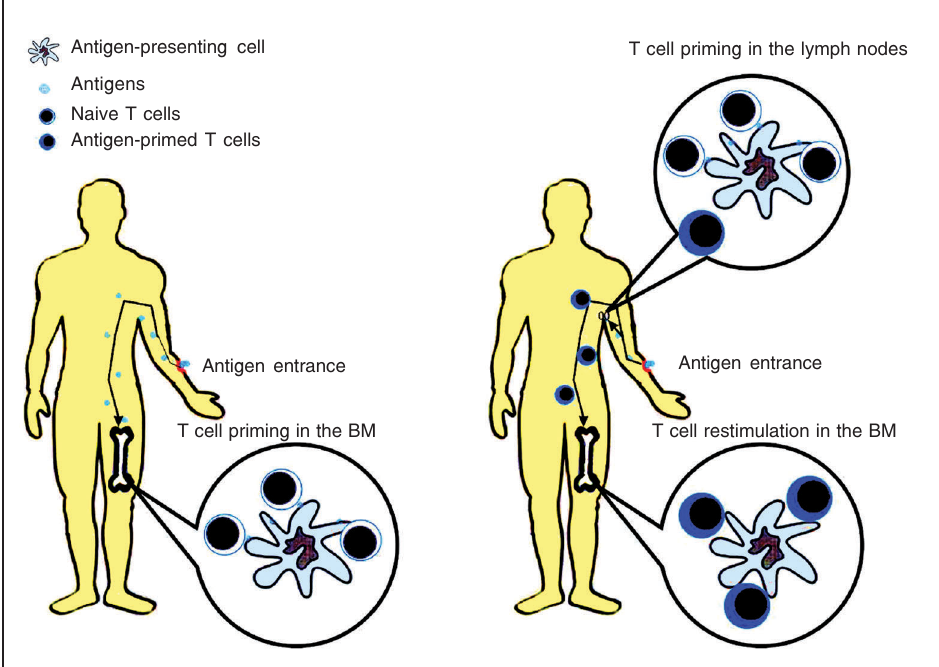
Figure 2. Dynamics of bone mar- row T cell priming. The antigen could use the intravenous route to reach the bone marrow and prime specific T cells directly in the bone marrow (left). The anti- gens also could enter the body by a non-systemic route, i.e., subcutaneously, orally, or by the mucosal route. In this situation, T cells would be primed in the peripheral lymphoid organs, then migrate to the bone mar- row, where they would be re- stimulated to help hematopoie- sis. BM = bone